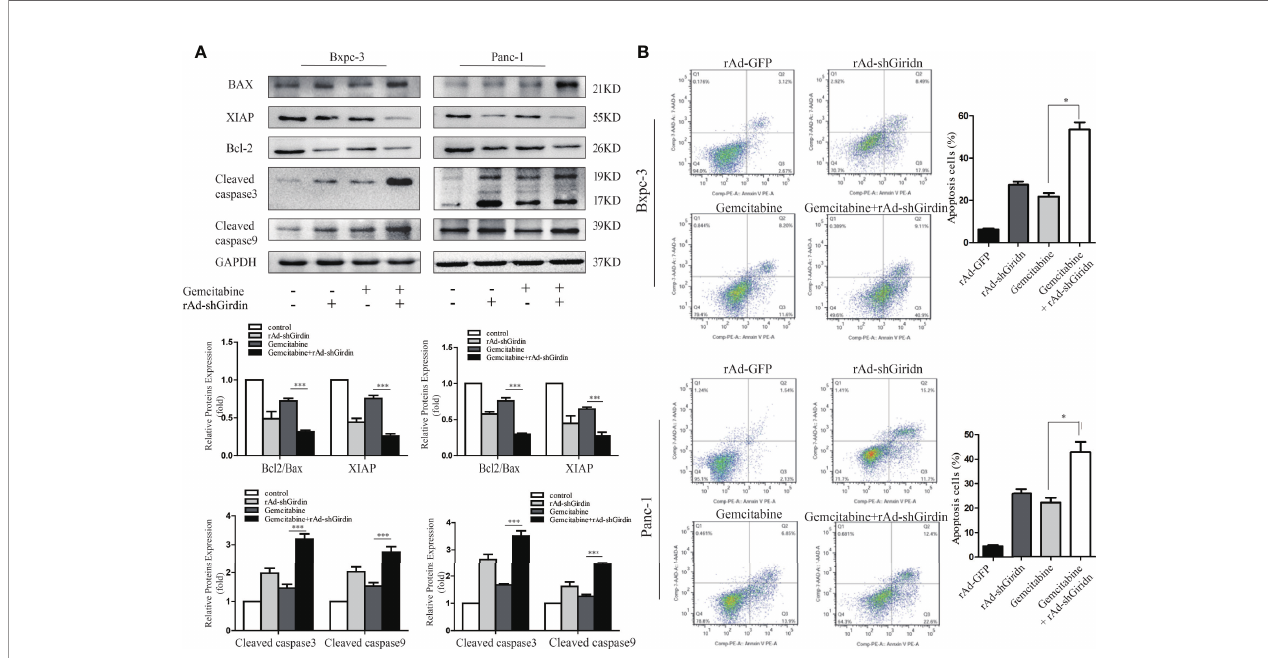
FIGURE 3 | Down-regulation of Girdin increase chemosensitivity of gemcitabine in pancreatic cancers. (A) Apoptosis related proteins were detected by western blotting after cells were treated with single rAd-shGirdin or gemcitabine treatment, and combination of the two. The combination treatment could induce apoptosis through down-regulating the Bcl-2/Bax ratio, XIAP and activating caspase-3 and caspase-9. (B) Cell apoptosis was determined by fl ow cytometry. The combination of rAd-shGirdin and gemcitabine could induce signi fi cant apoptosis compared with the cells treated with gemcitabine alone in pancreatic cancer. Each experiment was performed three times and all data were expressed as mean ± SEM; *P < 0.05, **P < 0.01, and ***P <